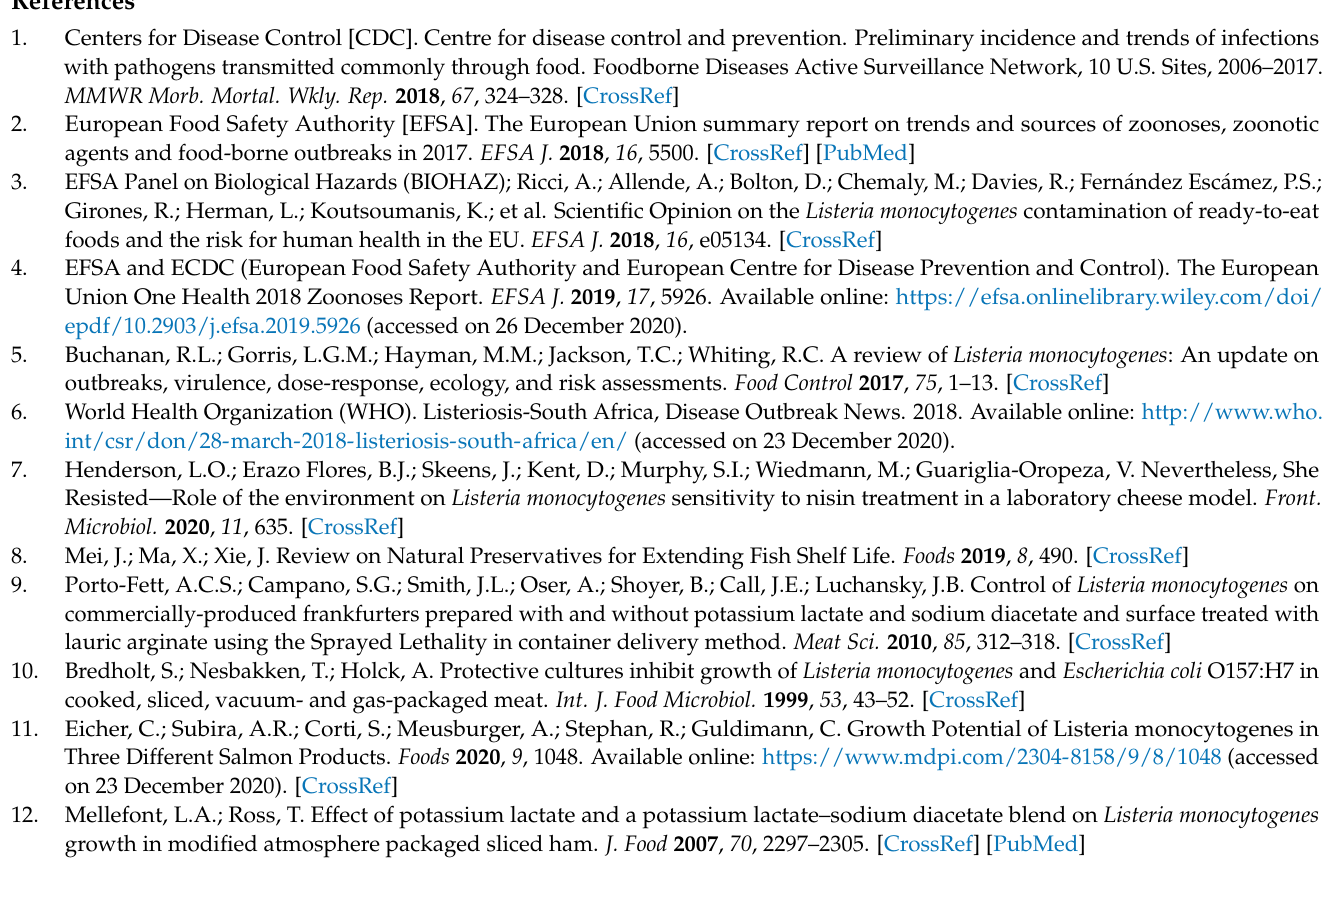
and firmness, Figure S5: Comparison of salami firmness or tenderness based on Warner-Bratzler measurements, Supplementary Table S1: Meat simulation broth composition, Supplementary Table S2: Salami reference recipe, Supplementary Table S3: Salami production conditions, Supplementary Table S4: Comparison of L. monocytogenes EGDe and LL195 growth in BHI at 37 ◦ C under NaCl and KL stress, Supplementary Table S5: Comparison of L. monocytogenes and L. innocua growth in BHI at 25 o C under NaCl and KL stress, Supplementary Table S6: Comparison of growth relative to 4% NaCl treated salami, Supplementary Table S7: Comparison of growth relative to day zero inoculum, Supplementary Table S8: Degree-hours